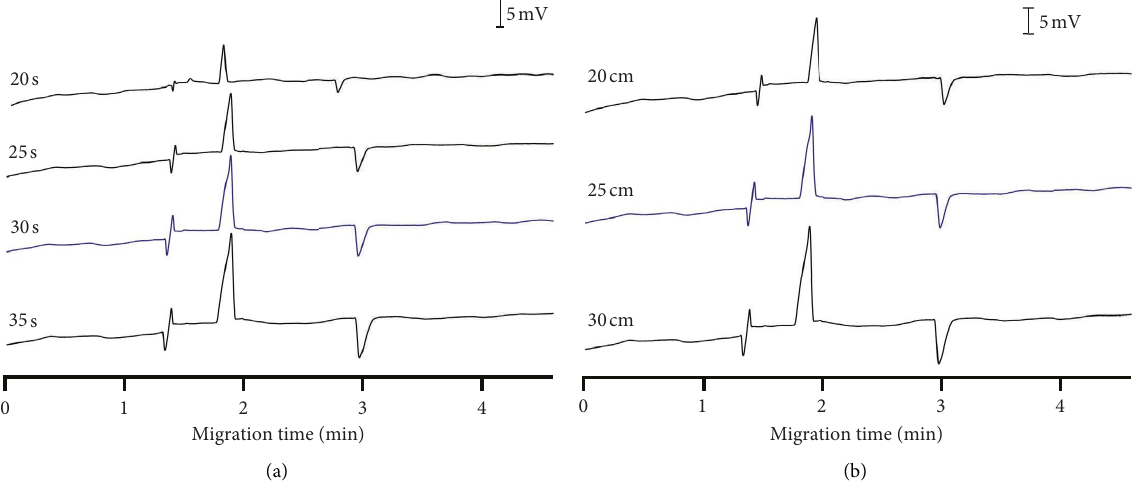
Figure 3: Efects of injection conditions on the CE-C 4 D analysis of glucosamine and calcium. (a) Injection time (siphoning at 25cm). (b) Siphoning height (injection time 30s). BGE conditions: 10mM Tris/Ace electrolyte solution, pH of 5.0, separation voltage of +20kV. Te selected conditions were highlighted in blue.